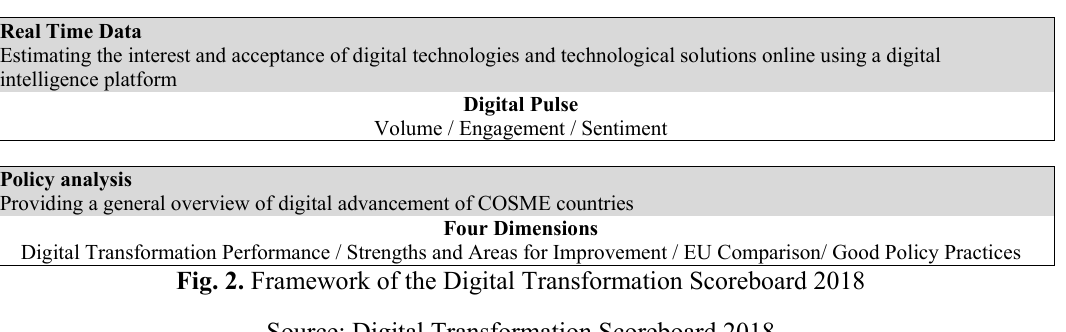
Fig. 2. Framework of the Digital Transformation Scoreboard 2018 Source: Digital Transformation Scoreboard